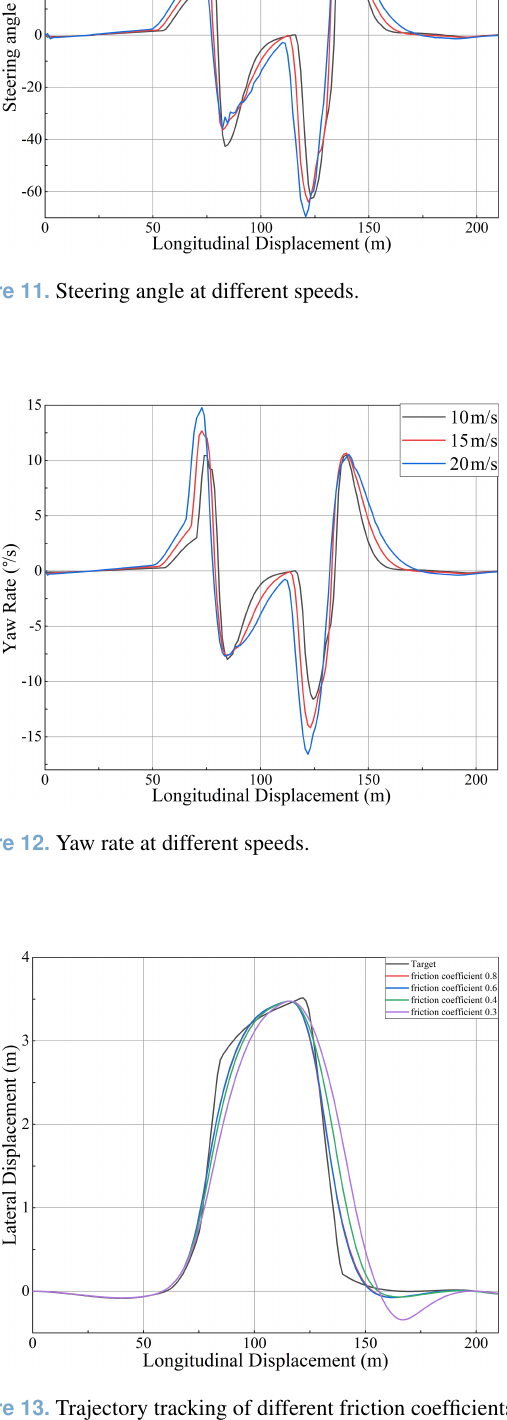
Figure 16. Yaw rate of different friction